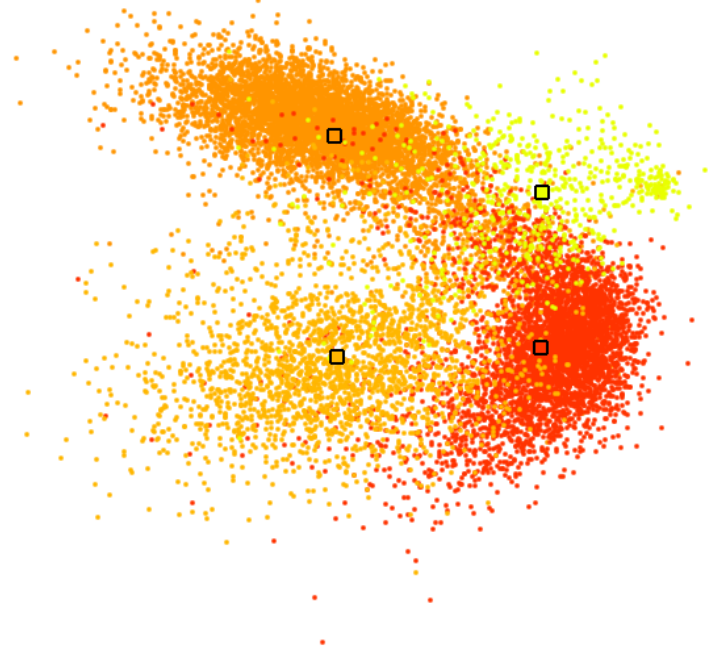
Figure 6. Linear embedding of labeled data, where color-coded labels correspond to interactively generated clusters in Figure 11b. Medians of labeled groups highlighted by black frames serve as control points for interactive cluster separation.